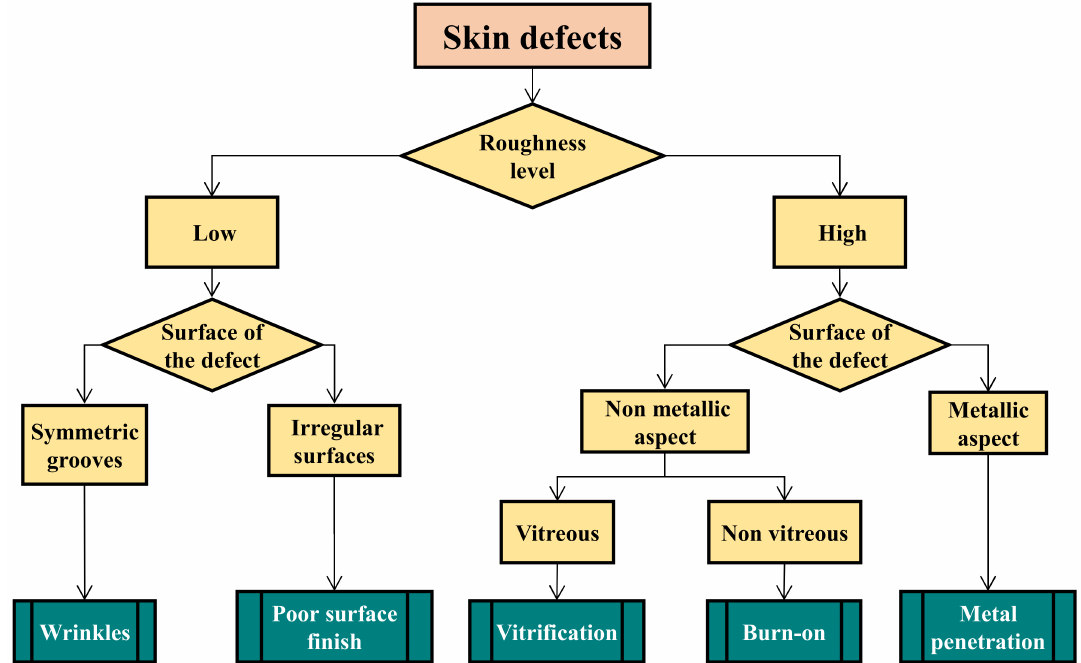
Figure 12. Classification of skin defects according to their